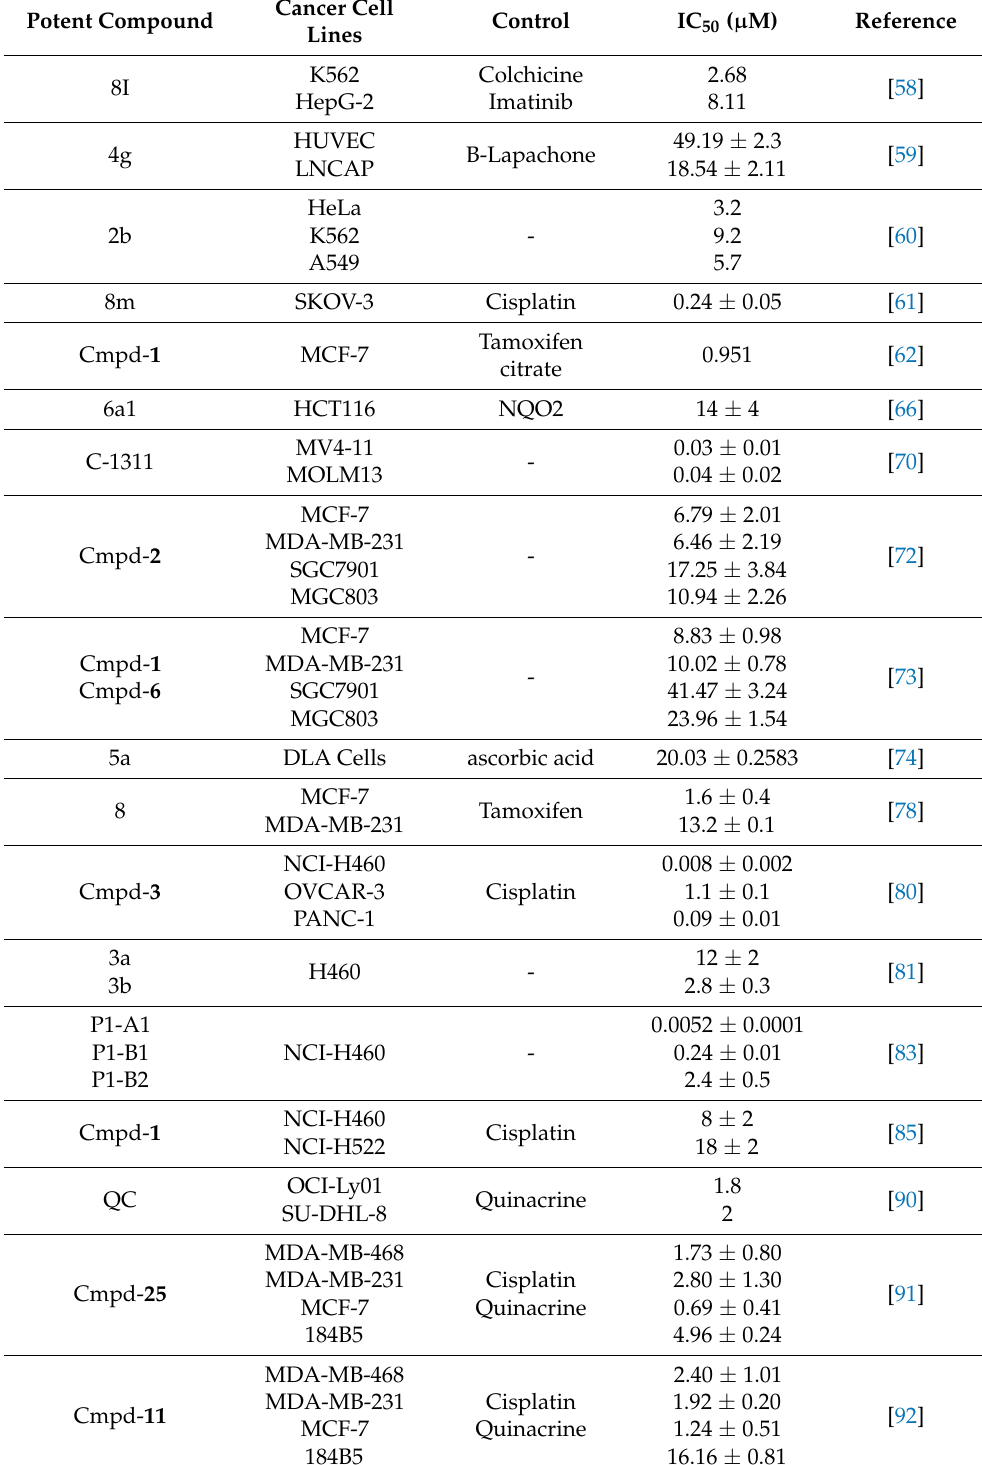
Table 16. Cont. Potent